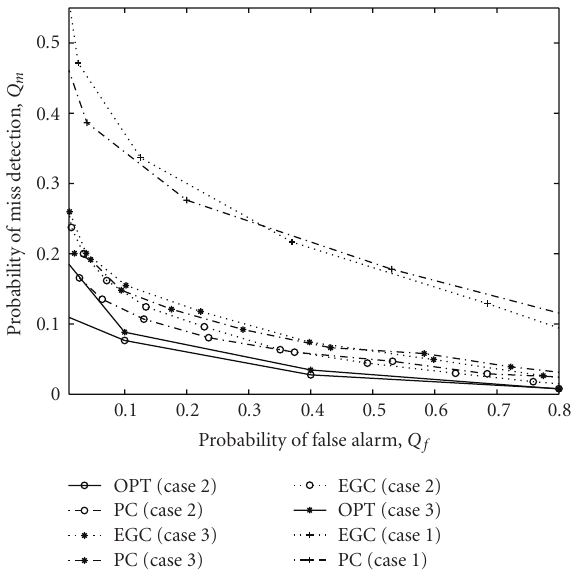
Figure 15: Receiver operating characteristics for collaborative spectrum sensing with perfect reporting channel, N = 10.